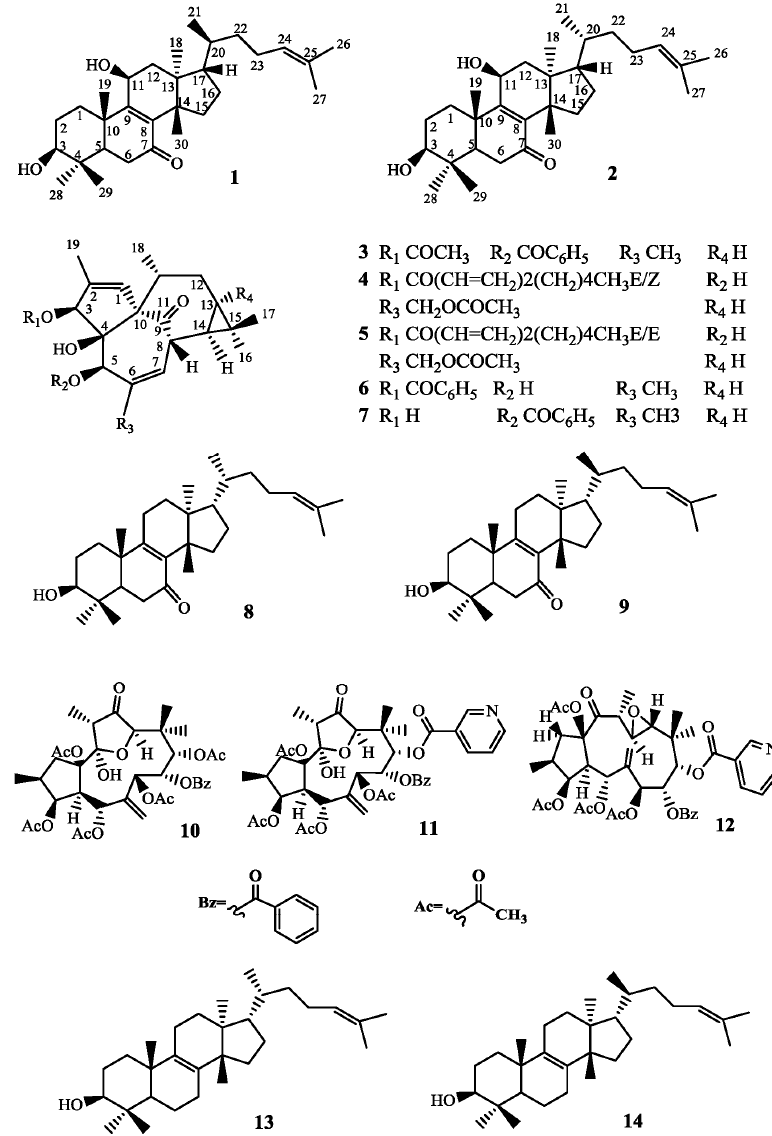
Figure 1. Chemical structures of Compounds 1 – 14 .